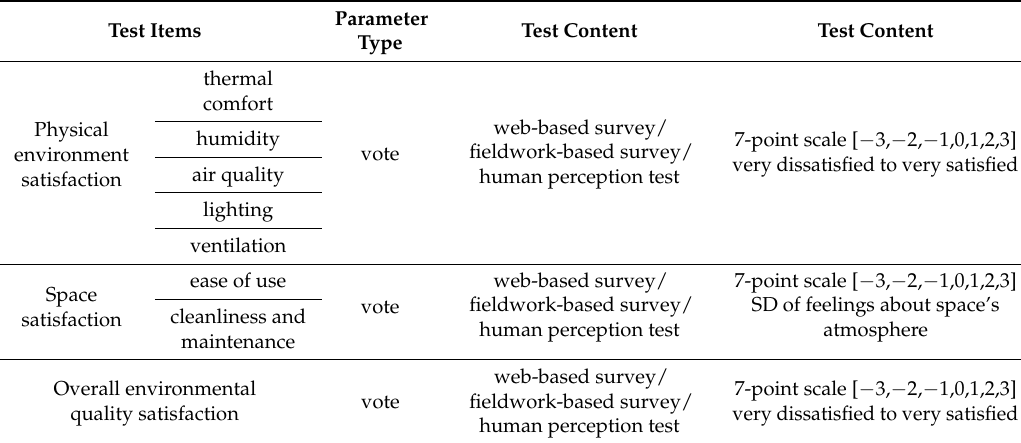
Table 3. Occupancy satisfaction voting